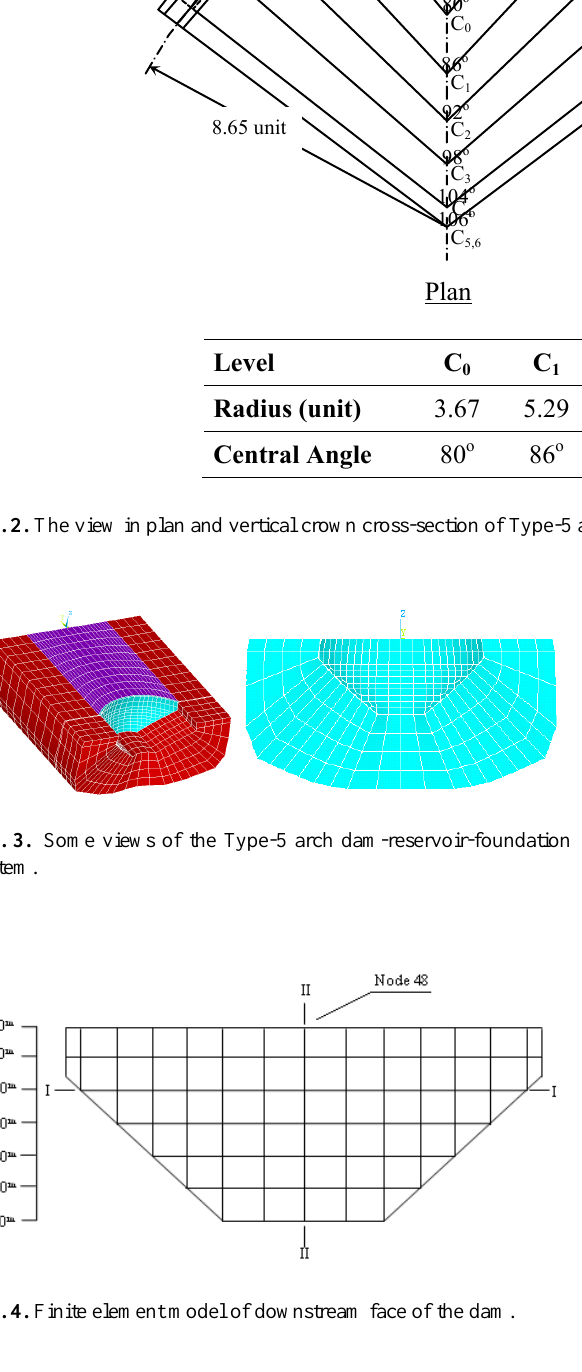
Fig. 4. Finite element model of downstream face of the dam.